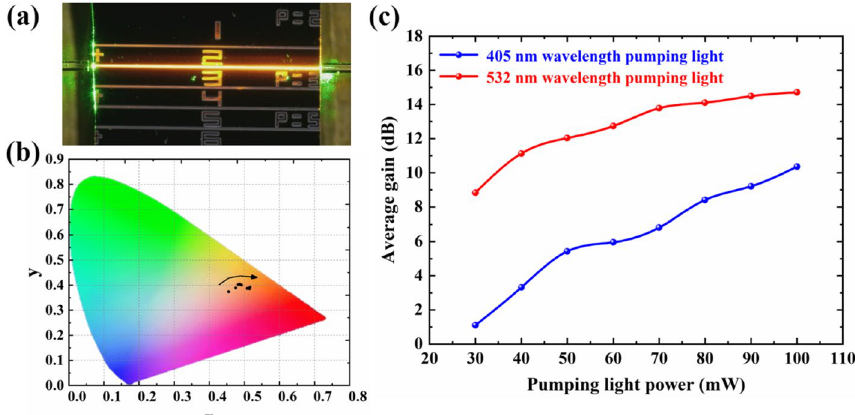
Fig. 8 a Image of active TCNzC/SU-8 waveguide excited by 532 nm wavelength pumping light; b the CIE chromaticity diagram coordinates of the spontaneous light; c comparison between the average gain values at 405 nm and those that at 532 nm wavelength pumping light from the output